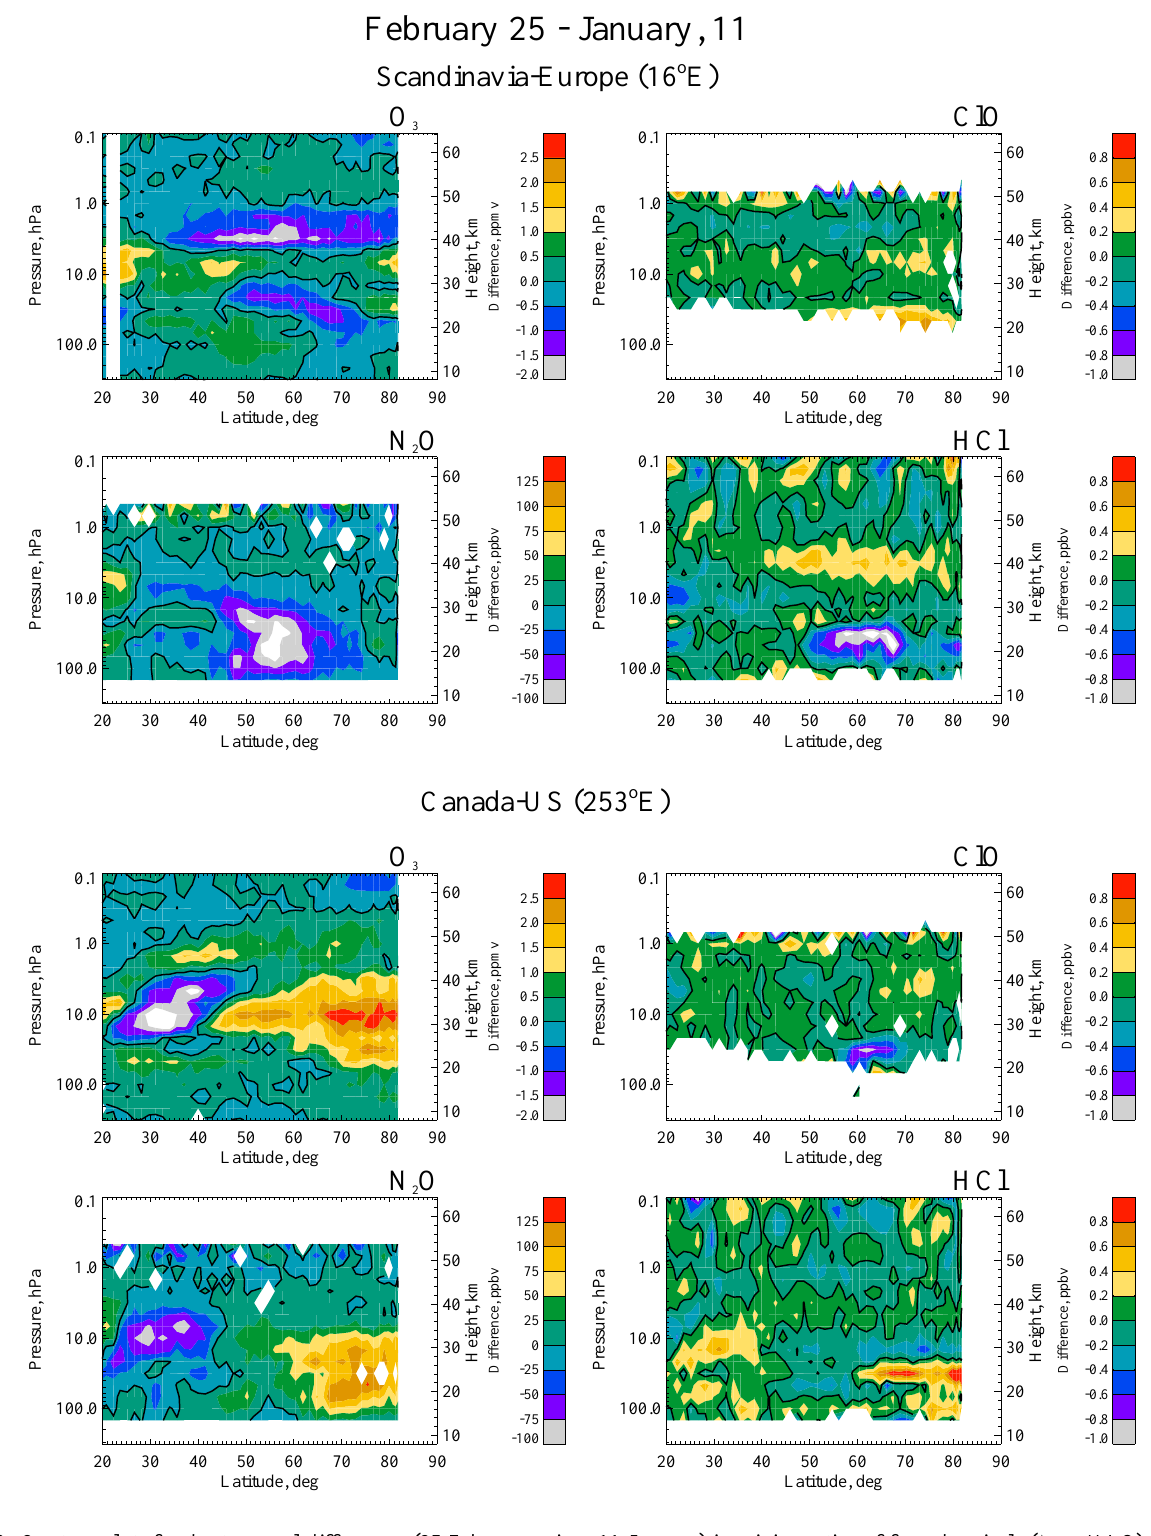
Fig. 8. Contour plots for the temporal differences (25 February minus 11 January) in mixing ratios of four chemicals (Aura MLS), at the chosen longitudinal sectors through Svalbard-Tromso-Collm (16 ◦ ± 12.5 ◦ E) and Saskatoon-Platteville (253 ± 12.5 ◦